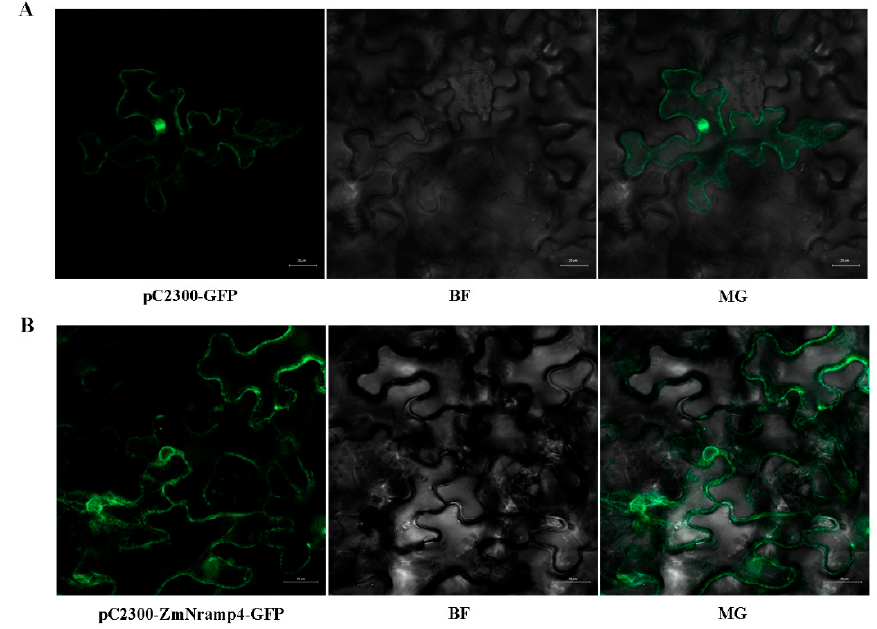
Figure 3. Subcellular localization of ZmNRAMP4 in tobacco leaves. The ZmNRAMP4 -GFP fusion protein was transiently expressed in the leaves of N. benthamiana (Scale bar: 50 µm).